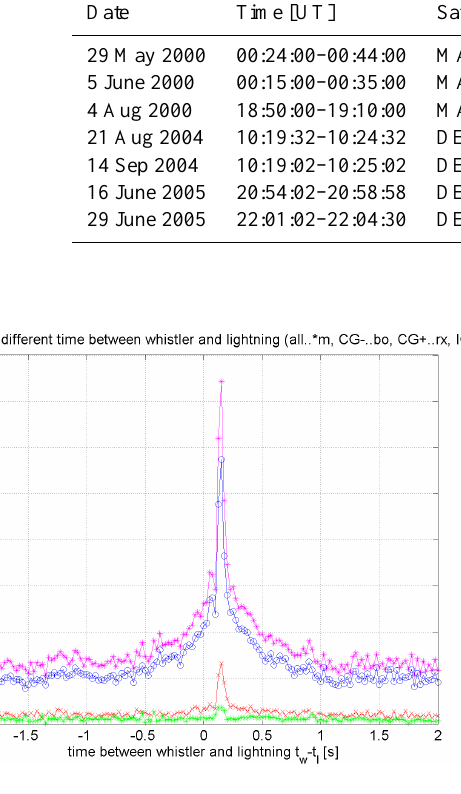
Fig. 4. Occurrence histogram of time differences t wi − t lj be- tween whistler observation ( t wi ) and lightning discharge detec- tion ( t lj ) . The histogram corresponds to the analysed period from 10:19:02 UT to 10:25:02 UT on 14 September 2004 and to the VLF record by DEMETER. The meaning of symbols and colours is the same as in Fig.